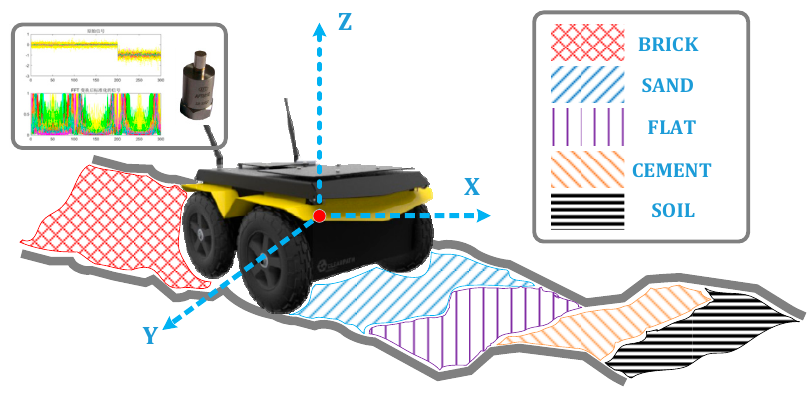
Figure 1. Experimental flow diagram.